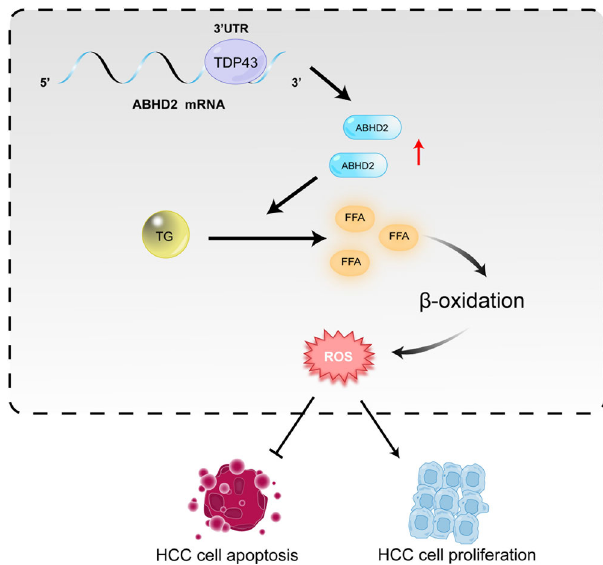
Fig. 9 Schematic diagram of TDP-43 suppressing apoptosis by modulating ABHD2 in HCC. TDP-43 binds with the 3 ʹ UTR of ABHD2 mRNA to enhance its mRNA stability, thereby upregulating ABHD2 expression. Elevated-ABHD2 catalyzes the metabolic process of TG to FFAs, thus promoting the β -oxidation pathway and increasing the production of ROS, fi nally resulting in the suppression of apoptosis and facilitation of proliferation in